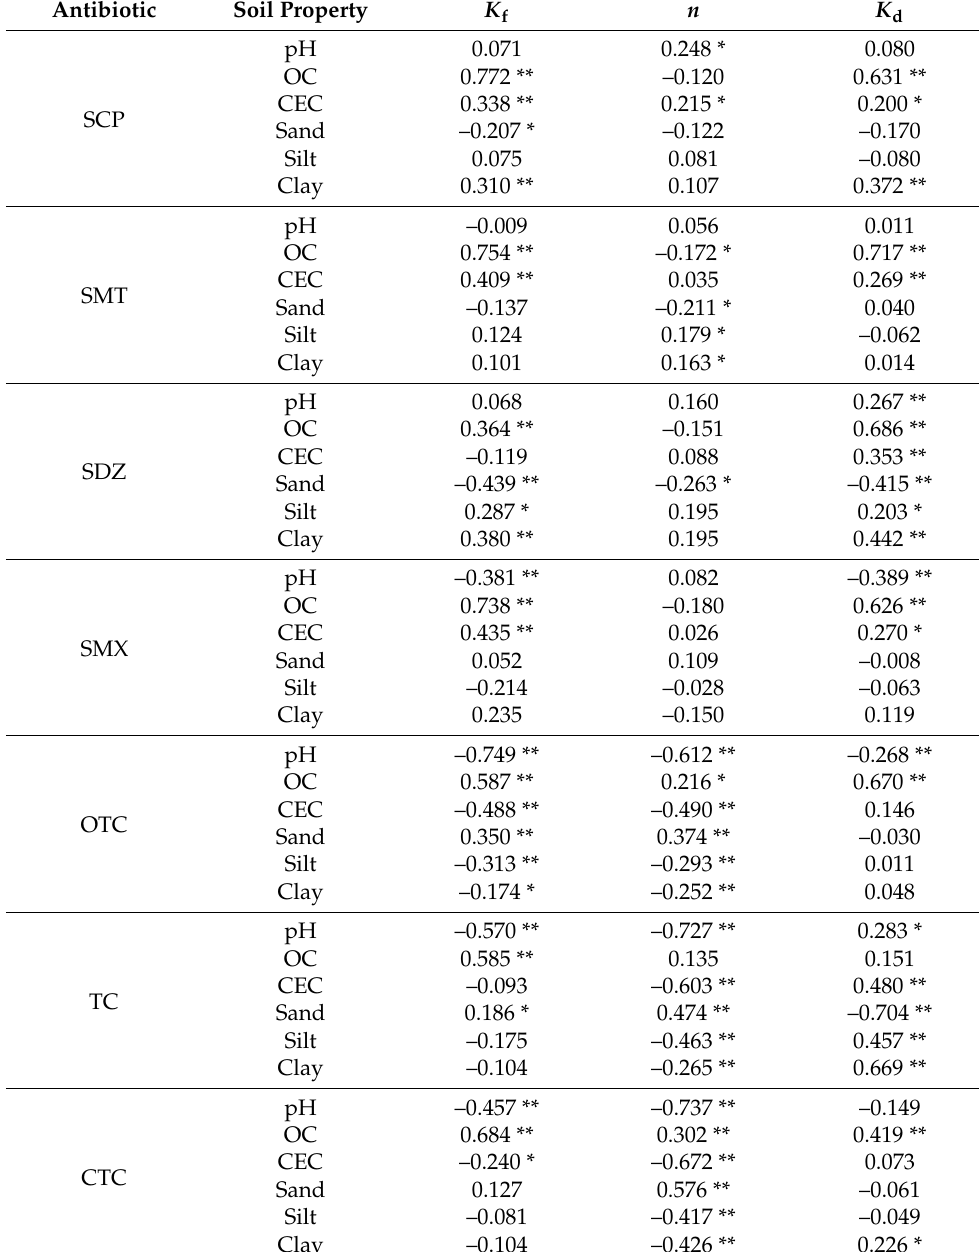
Table 3. Pearson correlation coefficients ( r ) of sorption parameters with soil